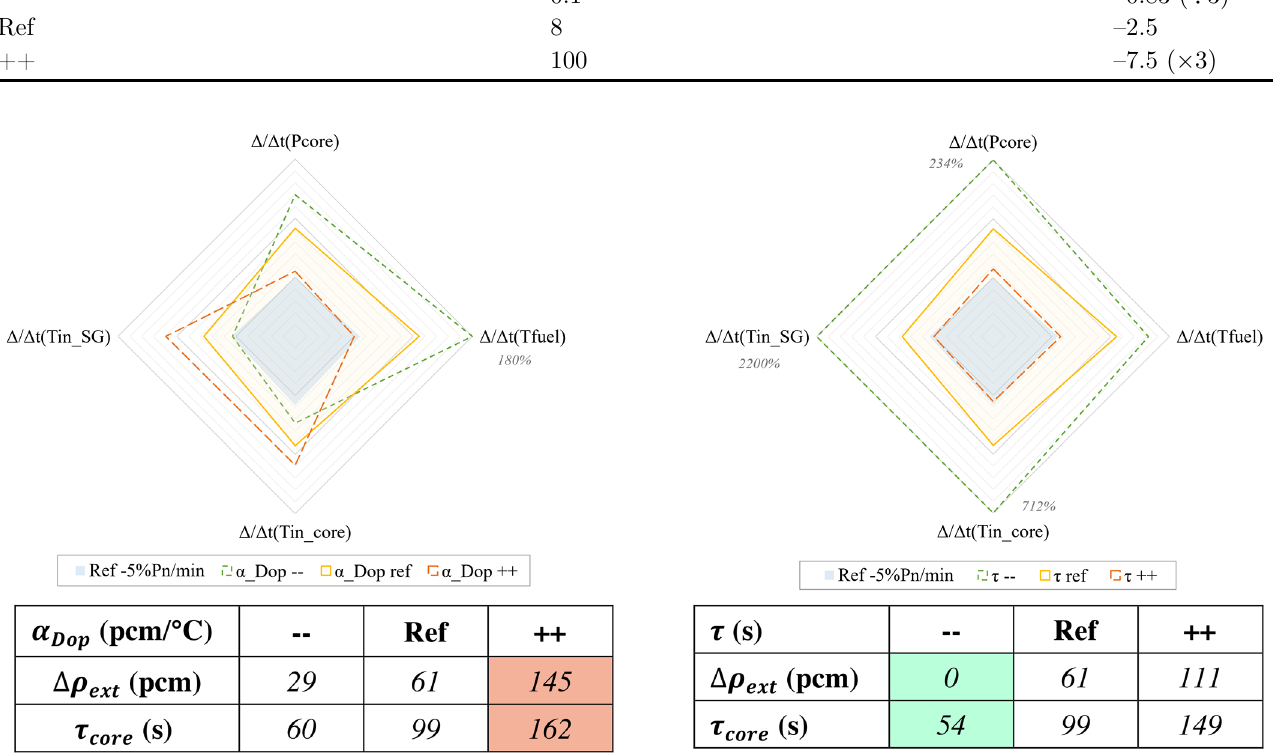
Fig. 13. Radars for the sensitivity study according to both studied